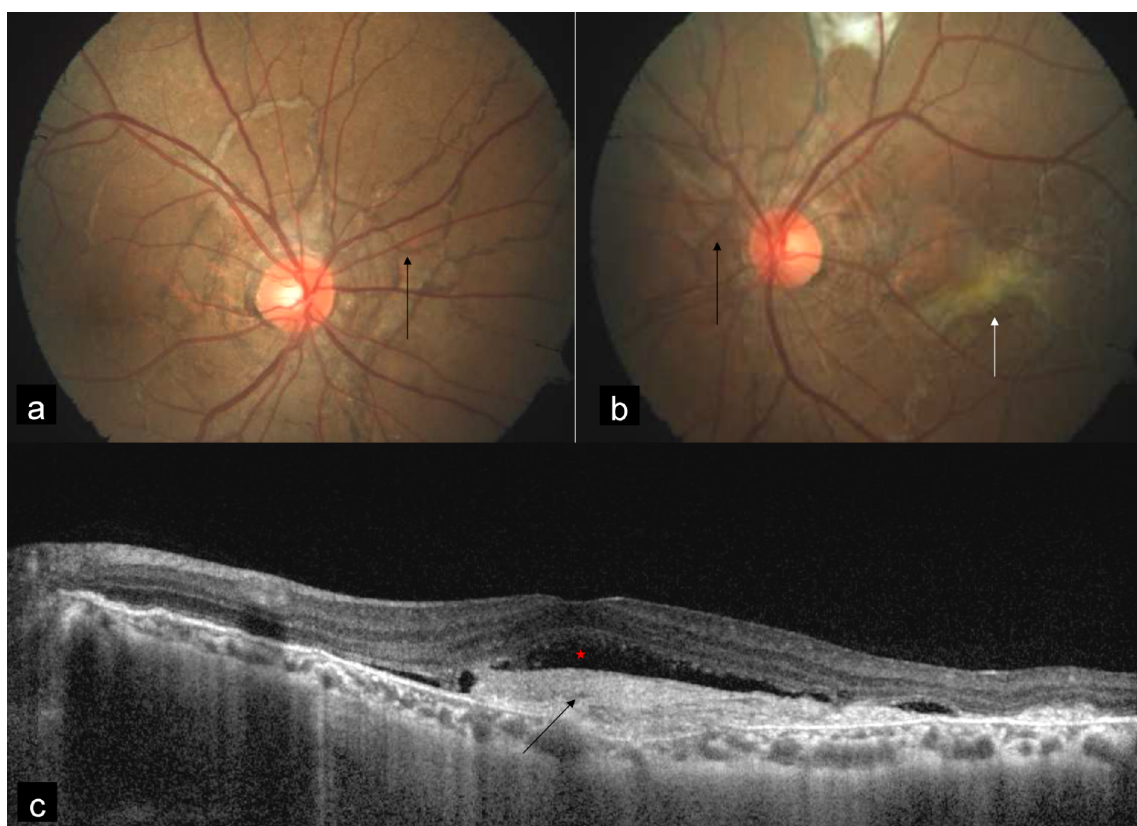
Figure 1: Color fundus photograph (CFP) showed angioid streaks (AS) in the right eye (a) and the left eye (b) (black arrows), and choroidal neovascular membrane (CNV) (white arrow) in the left eye (b). Spectral domain optical coherence tomography SD-OCT (c) showed CNV (black arrow) with subretinal fluid (red star).